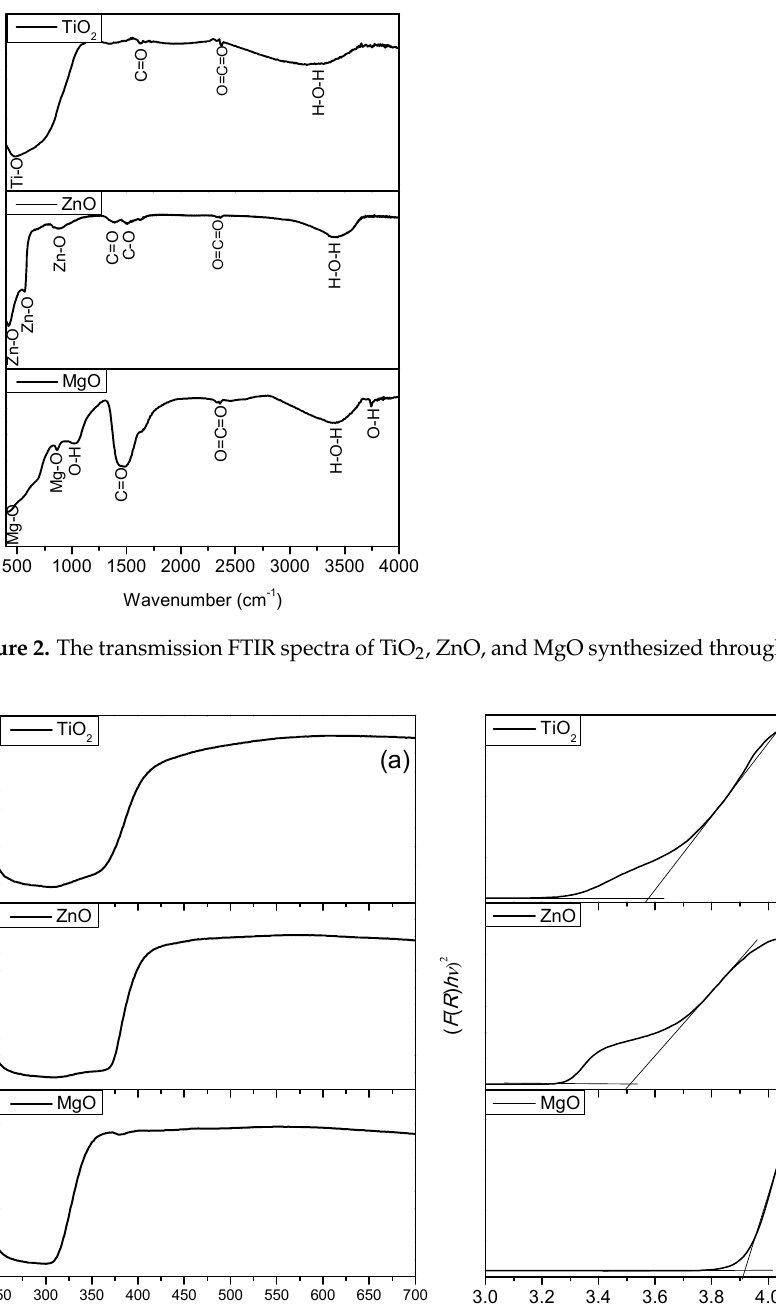
Figure 3. UV–Vis spectra ( a ) and band gap energies ( b ) of studied materials. The materials were degassed for 5 h at T = 100 °C with Nova1200e apparatus and analyzed at 77 K with nitrogen. The BET method was used for evaluating the surface area, and BJH was used for pore size distribution. The total pore volume was obtained from the last point of adsorption branch from hysteresis near 1 P / P 0 . Adsorp- tion–desorption isotherm obtained after performing the analysis was presented in Figure 4. In the inset of Figure 4, the average distribution of pores was shown. TiO 2 isotherm is of type IVa with hysteresis of type H2b, according to IUPAC classification [40]. In the case of a Type IVa isotherm, capillary condensation was accompanied by hysteresis. This occurs when the pore width exceeds a certain critical width, which is dependent of the adsorption system and temperature [41–43].